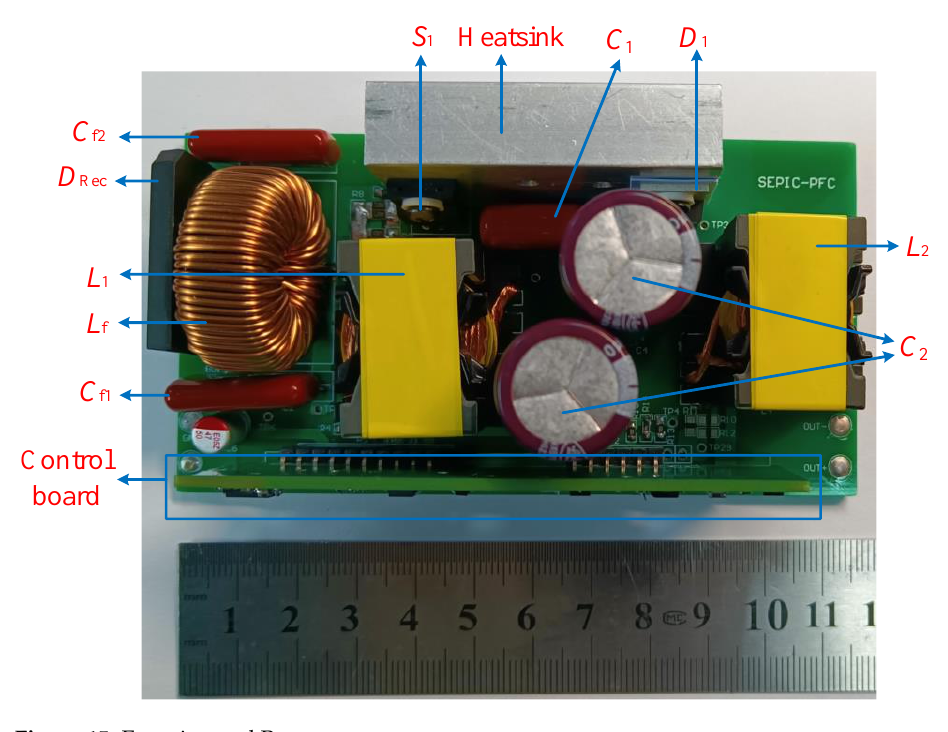
Figure 15. Experimental Prototype .